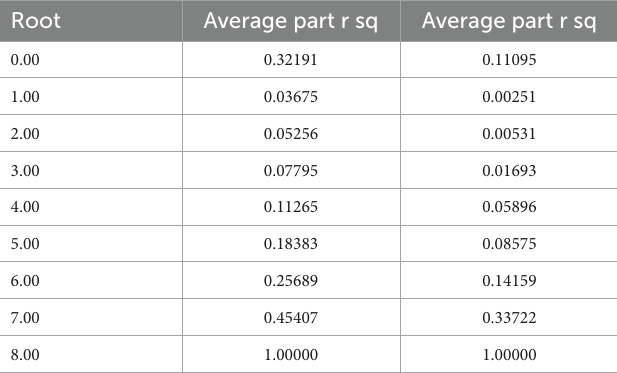
TABLE 4 Velicer minimum average partial (MAP) test. Root Average part r sq Average part r sq